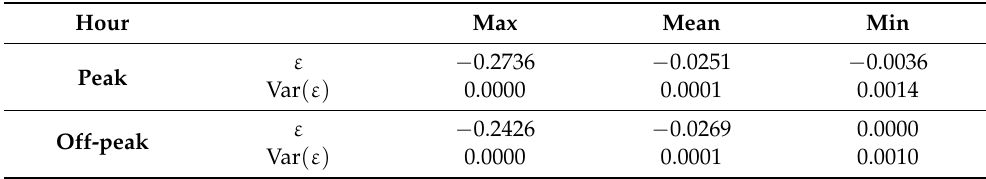
Table 7. Summary Statistics of the Hourly Elasticity Estimates, Aggregated by Peak and Off- peak